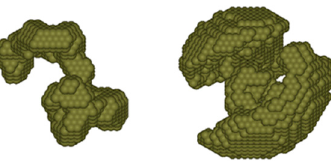
Figure 8. Possible conformations of the molecular ( left ) and aggregated ( right ) forms of sMyBP-C. SAXS data were assessed using the DAMMIF program [43].